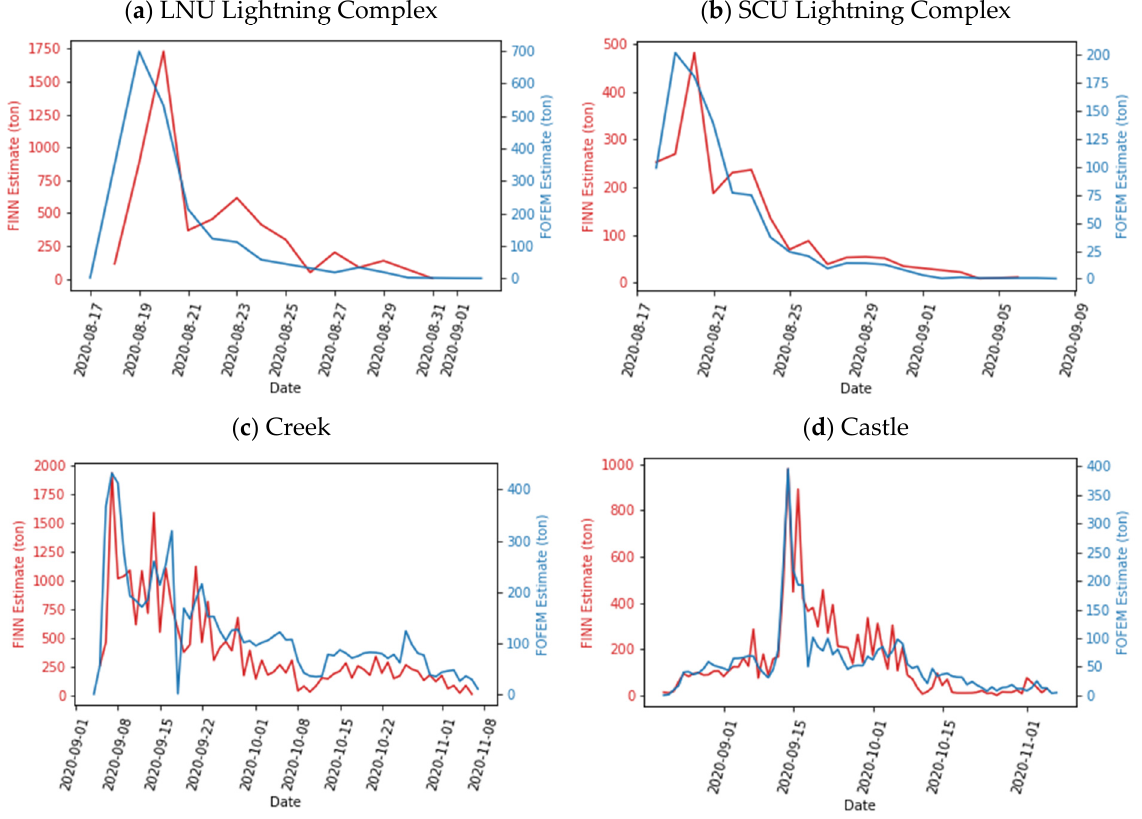
Figure 5. ( a ) Daily PM2.5 emission estimates from ( a ) LNU, ( b ) SCU, ( c ) Creek, and ( d ) Castle fires.